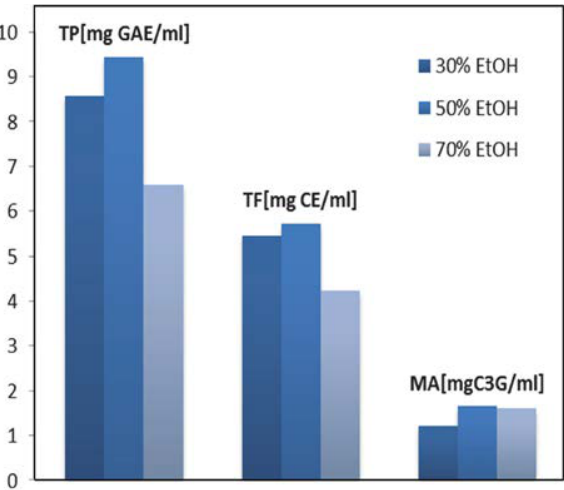
Figure 1. Extraction yields of desirable groups of compounds ob- tained with different concentration (30, 50 and 70%) of ethanol for 24 h